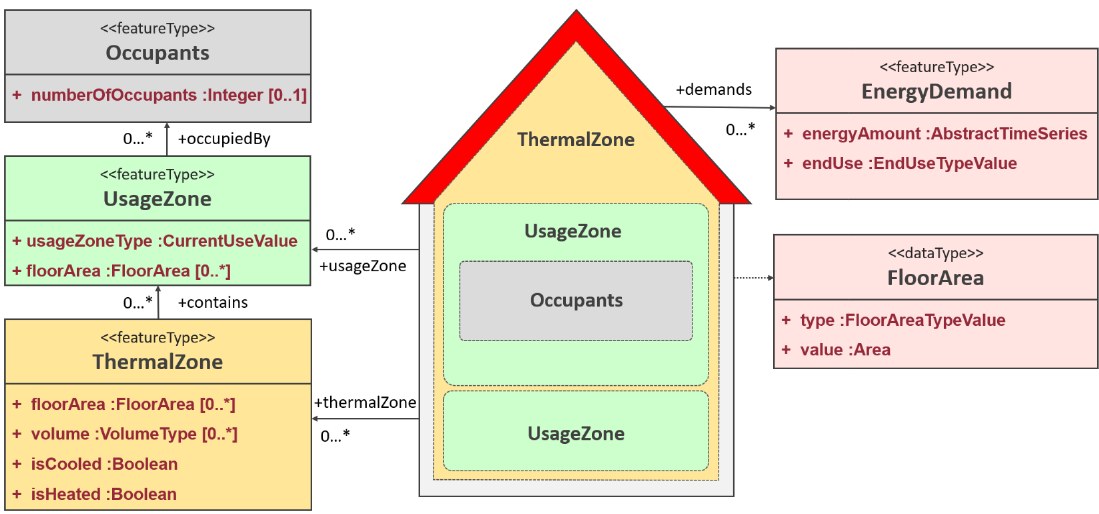
Figure 4. Simplified CityGML building with used Energy ADE